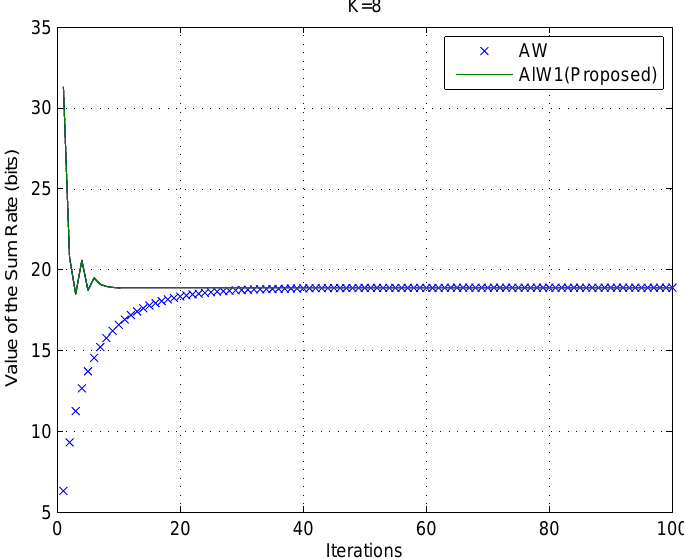
Figure 4. Algorithm ALW1compared with Algorithm AW, as K =